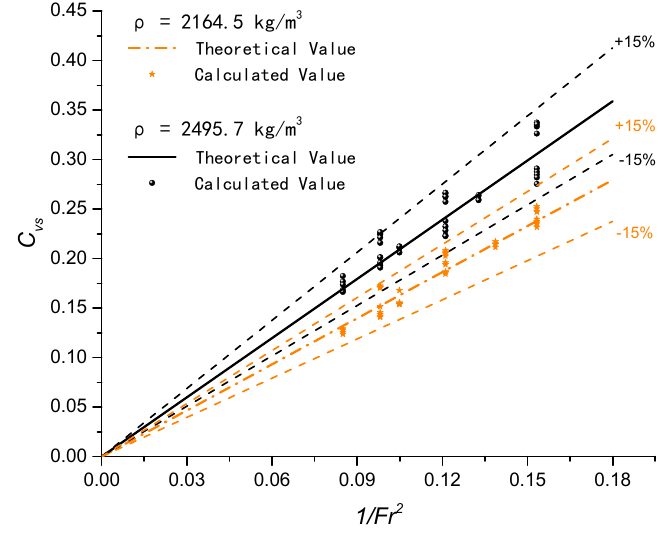
Figure 14. Relations between C vs and 1/ Fr 2 .